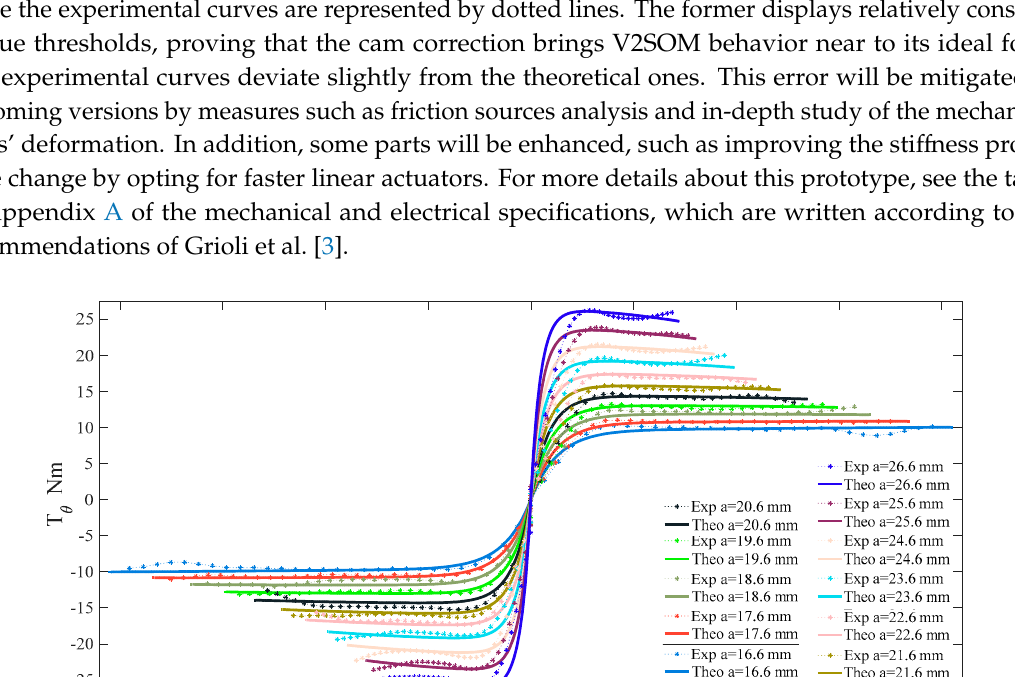
Figure 14. V2SOM first prototype.